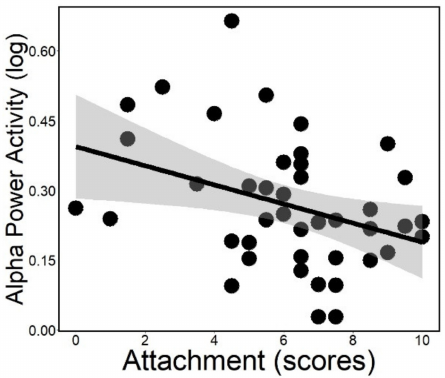
Figure 4. Alpha power activity plotted as a function of attachment scores measured in the Strange Situation Test. Gray area: 95% confidence interval from standard